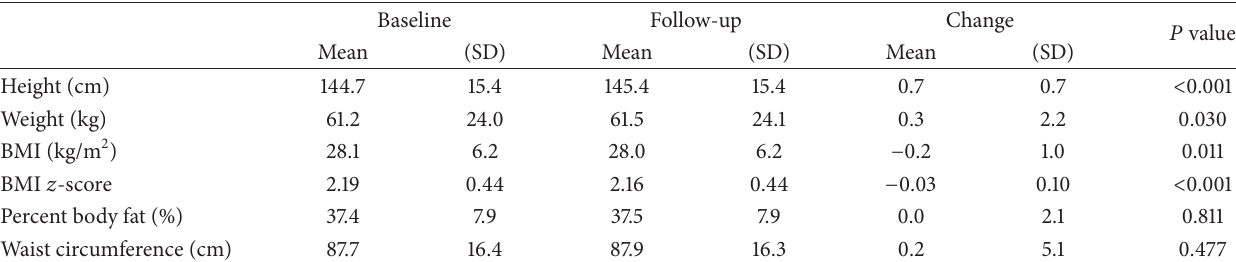
Table 6: Anthropometry changes among youth who completed FitKids360. Baseline Follow-up